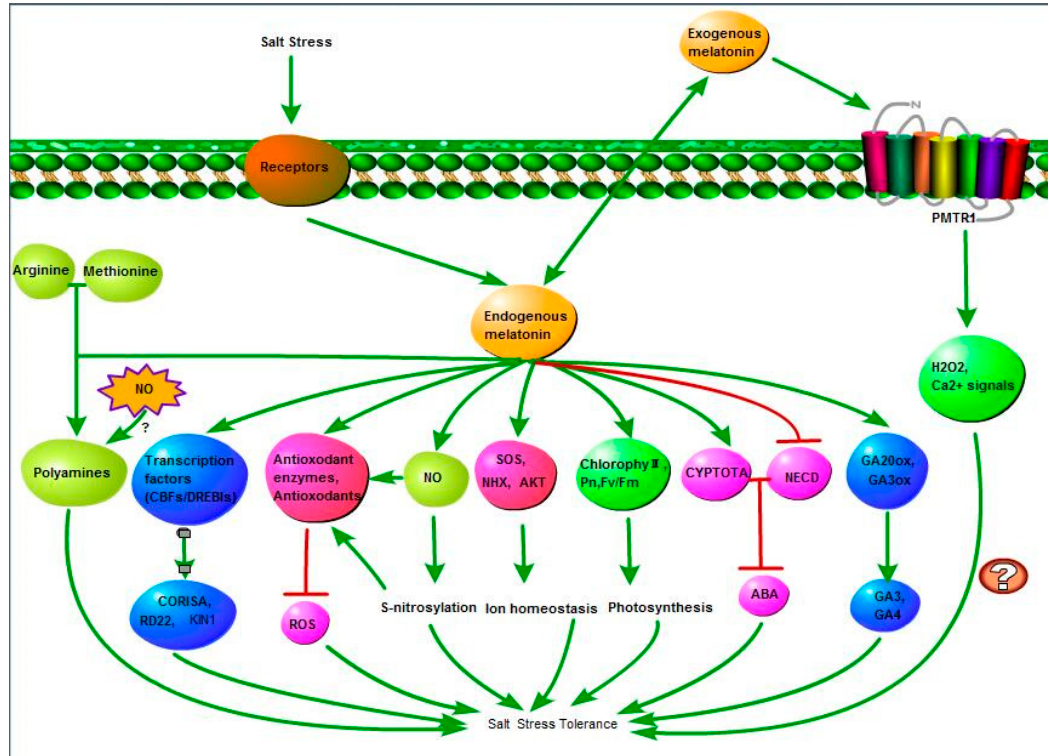
Figure 4. Melatonin-mediated salt stress response in plants. Abbreviation: NO, nitric oxide; ROS, reactive oxygen species; Pn, net photosynthetic rate; ABA, abscisic acid; GA, gibberellin acid. ⊥ : represents inhibition; and → : represents promotion.